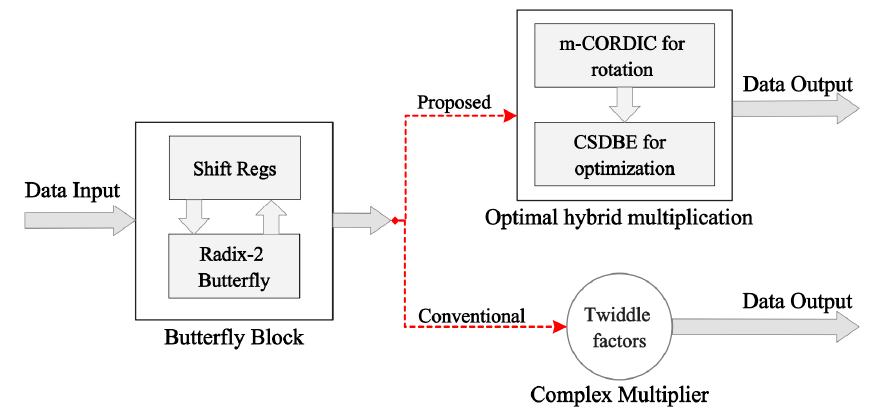
Figure 7. Block diagram of the R2DIF, FB FFT processor (R2FB) pipelined stage with two different implementation approaches.